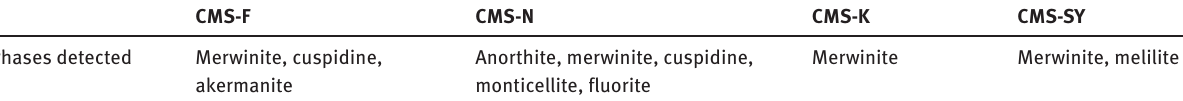
Table 5: Summary of phases detected by XRD for melted